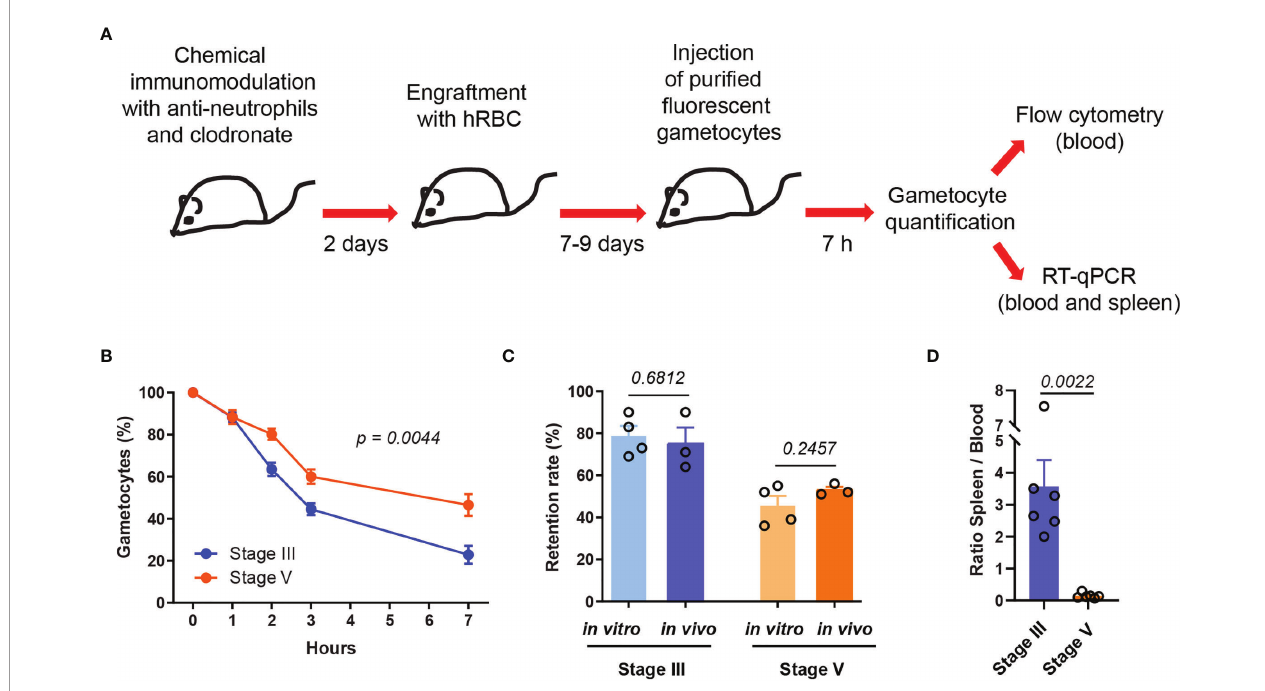
FIGURE 1 | Stiff immature GIE are cleared faster from the peripheral circulation than deformable mature GIE. (A) Schematic of experimental procedure for immunomodulation treatment and hRBC engraftment of NSG mice before injection with P. falciparum immature (stage III) and mature (stage V) fl uorescent gametocytes. (B) Quanti fi cation of GIE clearance in peripheral blood, comparing stage III GIE (blue) and stage V GIE (orange) by fl ow cytometry (n = 6 mice from 2 independent experiments). The percentage of gametocytes is normalized to the gametocytemia at 10 minutes after injection. p indicates the statistical signi fi cance determined using a two-way ANOVA test. (C) Retention rate of stage III and stage V GIE determined in vitro by microsphiltration (n = 4 fi ltration columns) and in vivo at 7hpi by fl ow cytometry (n = 3 mice). To determine GIE retention in vitro the upstream and downstream samples were smeared, stained with Giemsa and parasitemia was assayed by counting at least 2000 erythrocytes. (D) Quantitative analysis by real time RT-qPCR of GIE distribution in peripheral blood and spleen. Results were calculated as relative copy number of gfp or turbofp635 gene transcripts to the control housekeeping HK gene transcripts in spleen and blood samples. The graph represents the ratio spleen-to-blood for 6 mice from 2 independent experiments. In C and D, p indicates the statistical signi fi cance determined using a Mann Whitney test. Error bars show the standard error of the mean